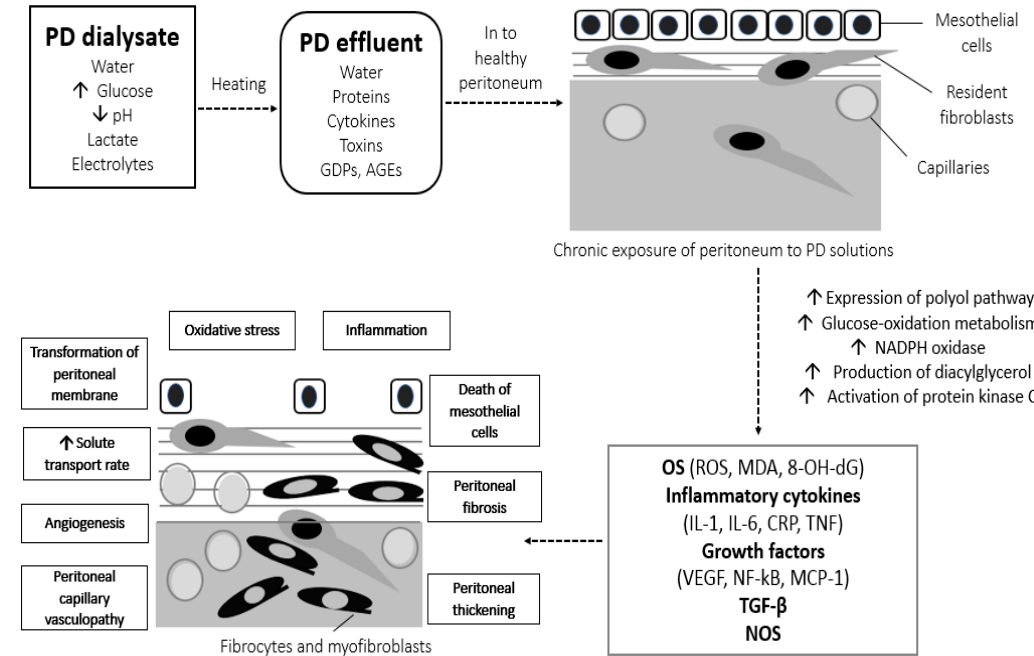
Figure 2. Local and systemic OS-derived complications of conventional hyperglycemic PD solutions. AGEs, advanced glycation end-products; CRP, c-reactive protein; GDPs, glucose degradation products; IL, interleukin; MCP-1, monocyte chemoattractant protein-1; MDA, malondialdehyde; NADPH, nicotinamide adenine dinucleotide phosphate; NF-kB, nuclear factor kB; NOS, nitric oxide synthase; OS, oxidative stress; PD, peritoneal dialysis; ROS, reactive oxygen species; TGF- β , transforming growth factor β ; TNF, tumor necrosis factor; VEGF, vascular endothelial growth factor; 8-OH-dG, 8-hydroxy-2 ′ -deoxyguanosine.